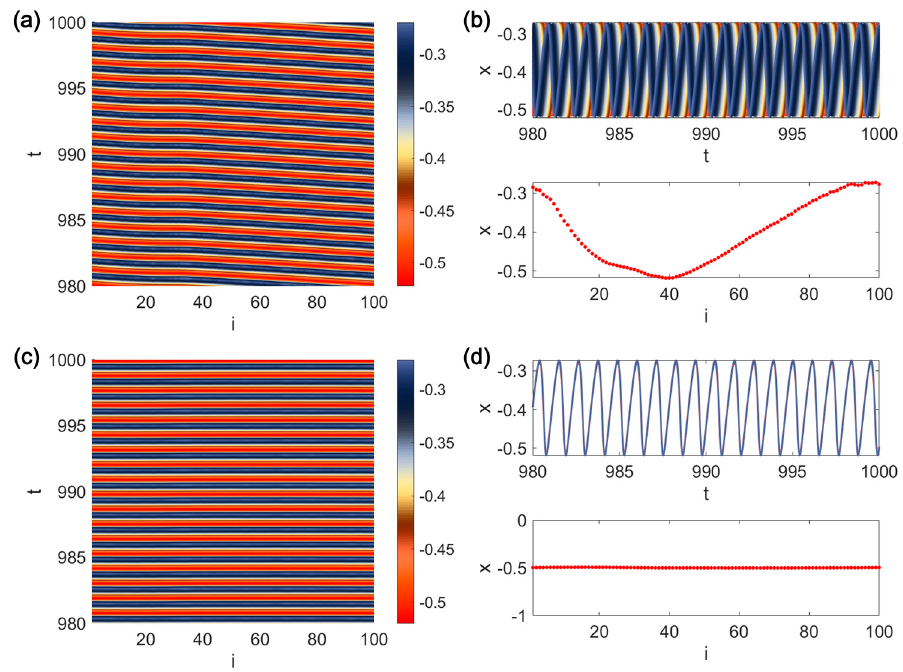
Figure 5. ( a ) The spatio-temporal patterns of locally coupled FMW neurons, as well as ( b ) the neurons’ time series and the snapshot of the last samples for 𝐷 = 3.5 . ( c ) The spatio-temporal patterns of locally coupled FMW neurons, as well as ( d ) the neurons’ time series and the snapshot of the last samples for 𝐷 = 30 . 𝛼 = 0.75 is considered.